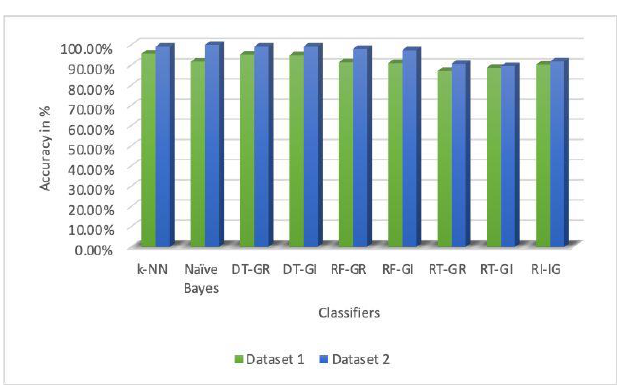
Fig. 3. Comparison in terms of accuracy of non-technical courses